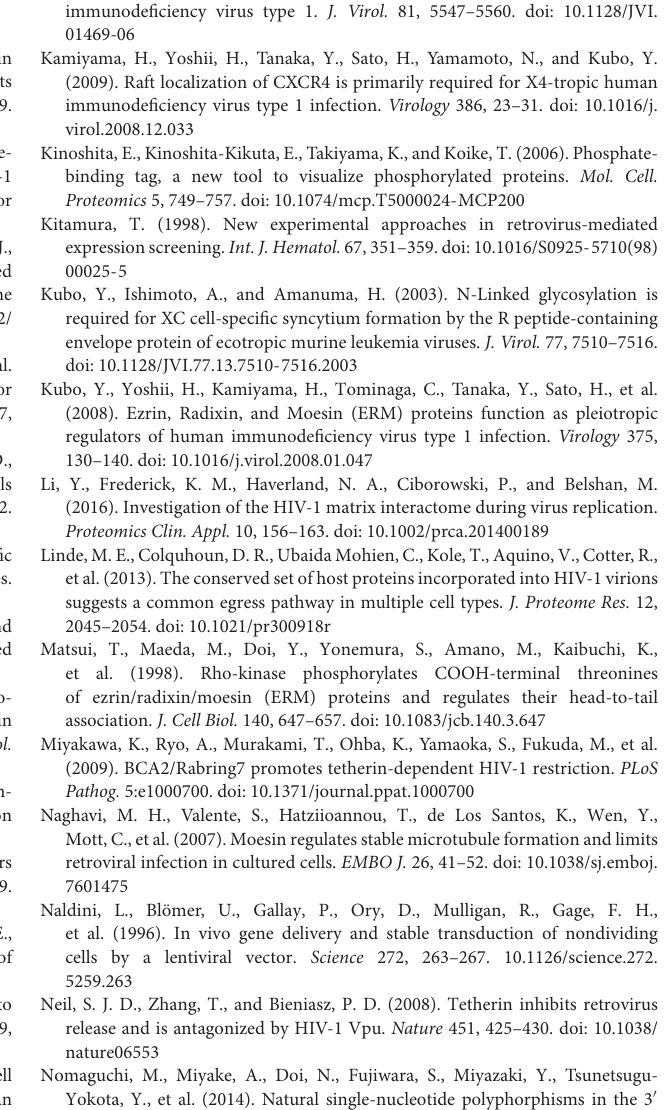
FIGURE S1 | Cellular localization of HIV-1 Gag and ezrin proteins. COS7 cells were transfected with the HIV-1 vector construction plasmids together with the EZ-Wt or EZ-TD expression plasmid, and permeabilized with methanol. The cells were first stained with mouse anti-VSV-G epitope and rabbit anti-HIV-1 p24 antibodies, and then with Cy3-conjugated anti-mouse IgG and FITC-conjugated anti-rabbit IgG antibodies. The cells were observed under a laser confocal microscope. Representative results are